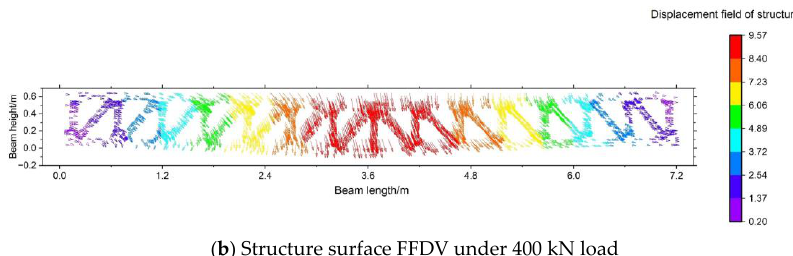
Figure 18. Structure surface FFDV under D01 condition.